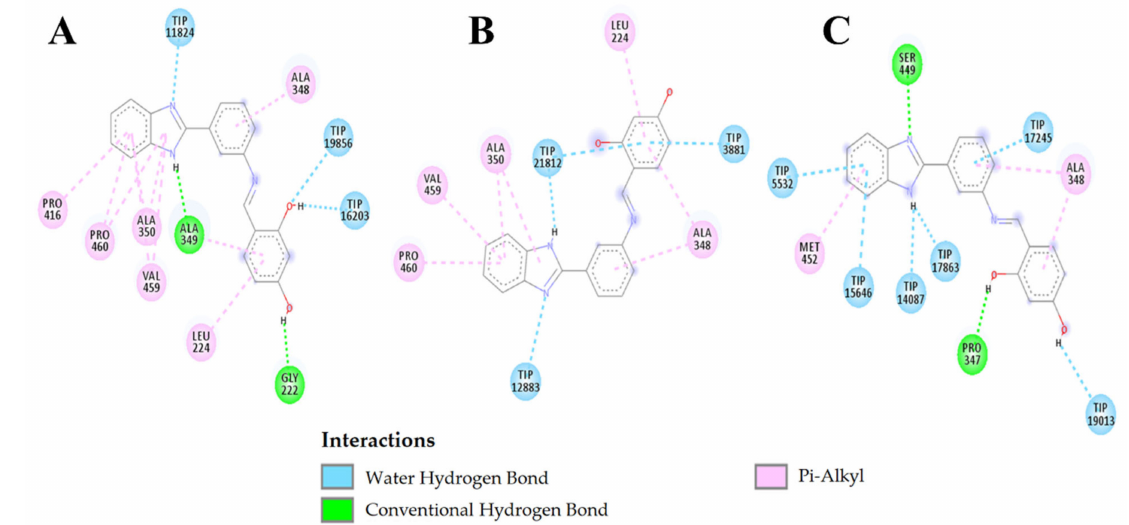
Figure 7. Interaction of the molecular dynamics between L2 and leishmanin. ( A ) at 0 ns; ( B ) at 5 ns; ( C ) at 10 ns. TIP: